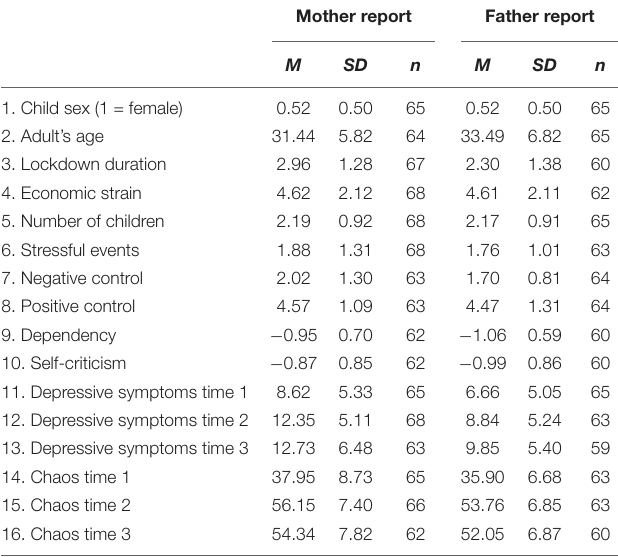
TABLE 2 | Descriptive data of mother’s and father’s characteristics and context.